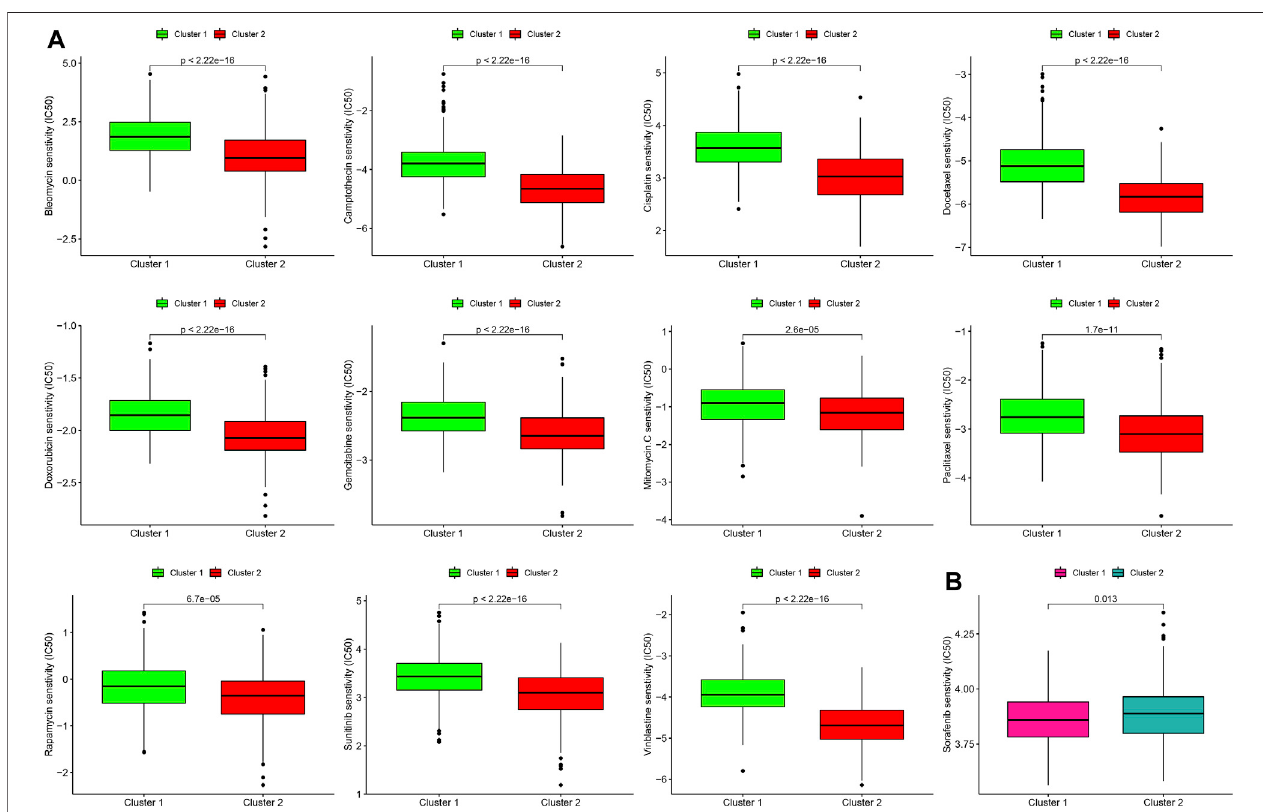
FIGURE 6 | Differences in the sensitivity of two molecular subtypes to chemotherapy. (A) Chemotherapeutic agents that CC cells in subtype 2 (C2) are more sensitive to. (B) Chemotherapeutic agents that CC cells in subtype 1 (C1) are more sensitive to.